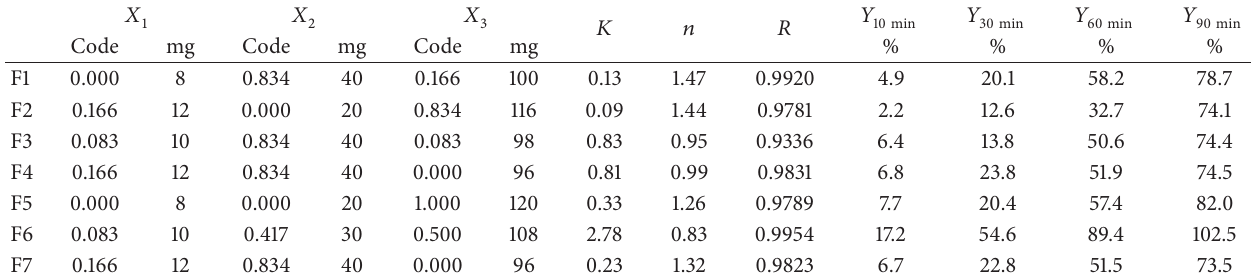
Table 2: The composition and dissolution parameters of isotretinoin oil-based